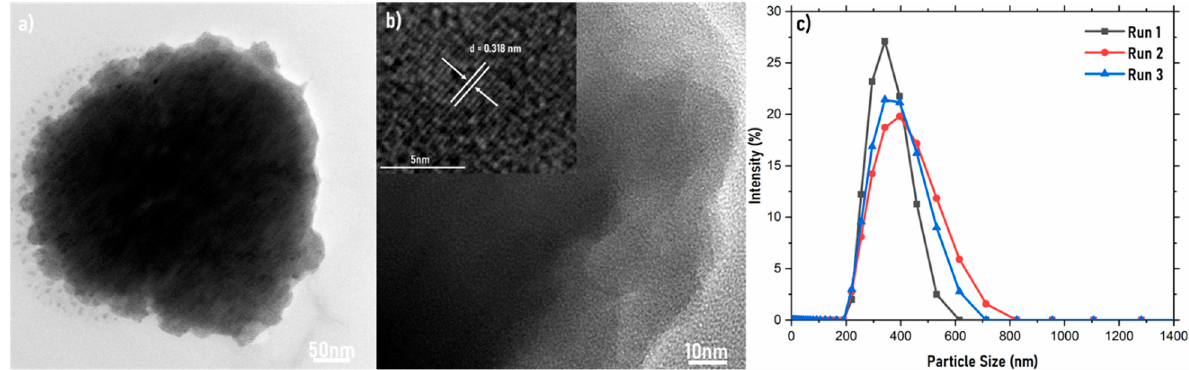
Figure 2. ( a ) TEM images of the synthesized material, ( b ) inset of the calculated lattice spacing, and ( c ) particle size anal- ysis.